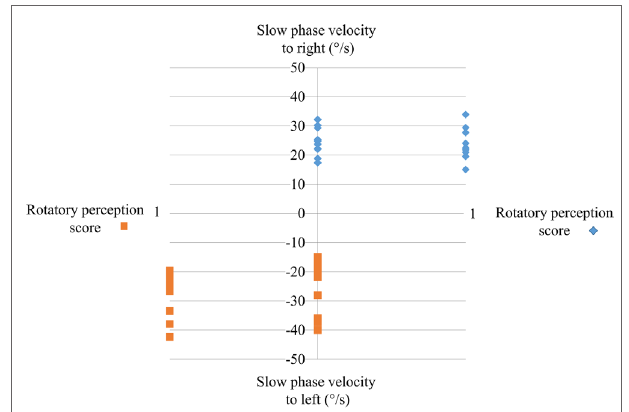
FigUre 2 | The perception of rotation score during caloric testing as a function of the peak of the slow-phase velocity. Ordinates: peak SPV induced by warm water irrigation of the right or the left ear; abscissa: perception rotation score during irrigation. Note that the seniors with postural instability did not perceive any rotation (score 0) irrespective of whether the left or right ear was irrigated; all controls perceived